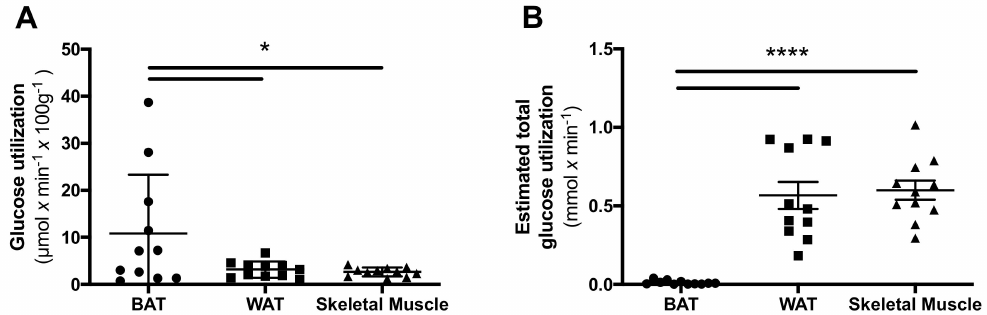
Figure 4. Glucose utilization in di ff erent important tissue compartments. The glucose utilization per gram tissue was found to be highest in brown adipose tissue (BAT), compared to white adipose tissue (WAT) and skeletal muscle ( A ). However, when estimating the total body contribution of glucose utilization in each tissue the contribution of BAT was minimal ( B ). * denotes p < 0.05, and **** p <